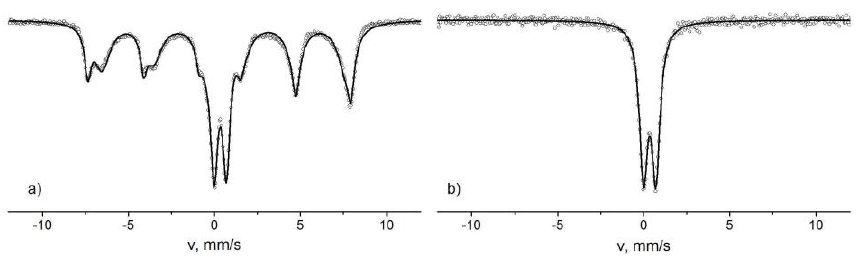
Figure 5. Mössbauer spectra of Fe 3 O 4 nanoparticles d ≈ 13 nm ( a ) and γ-Fe 2 O 3 d ≈ 8 nm ( b ) measured at room temperature.